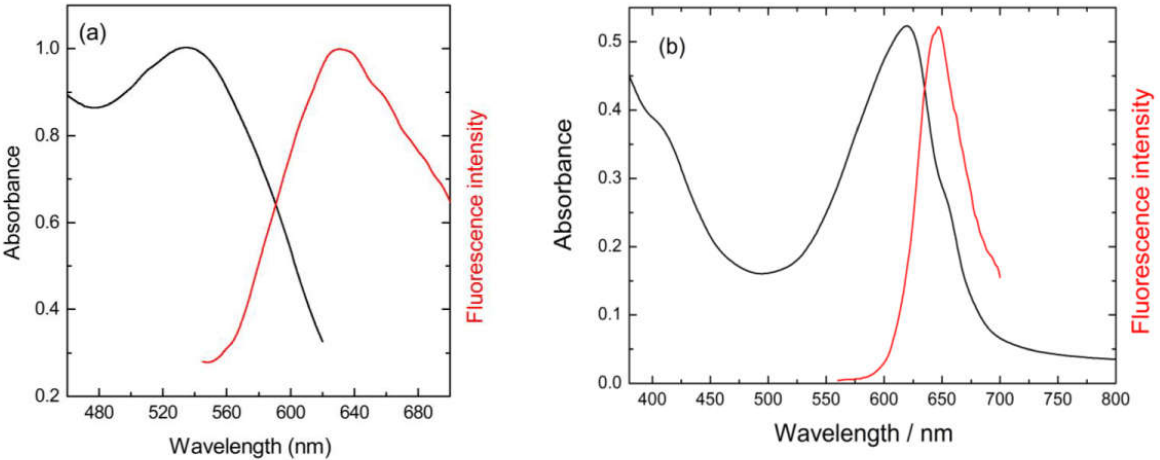
Figure 6. Normalized UV–visible absorption (black line) and emission spectra (red line) of ( a ) an ethanolic anthocyanins purified solution (mostly cyanidin-3-glucoside) and ( b ) of phycocyanin aqueous solution. The measured redox potentials allow the calculation of the exact value for the energy gap. The difference between the E anodic = 1.3 V and the E cathodic = − 0.8 V also gives an E 0-0 value of 2.10